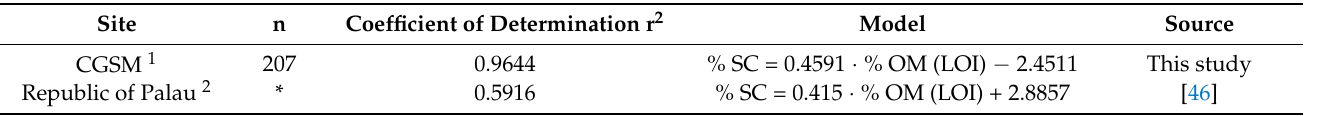
Table 4. Relationship between organic matter-OM (calculated via loss on ignition-LOI) and soil carbon concentration SC (%) (calculated via dry combustion) for mangrove soil samples. n = number of observations.